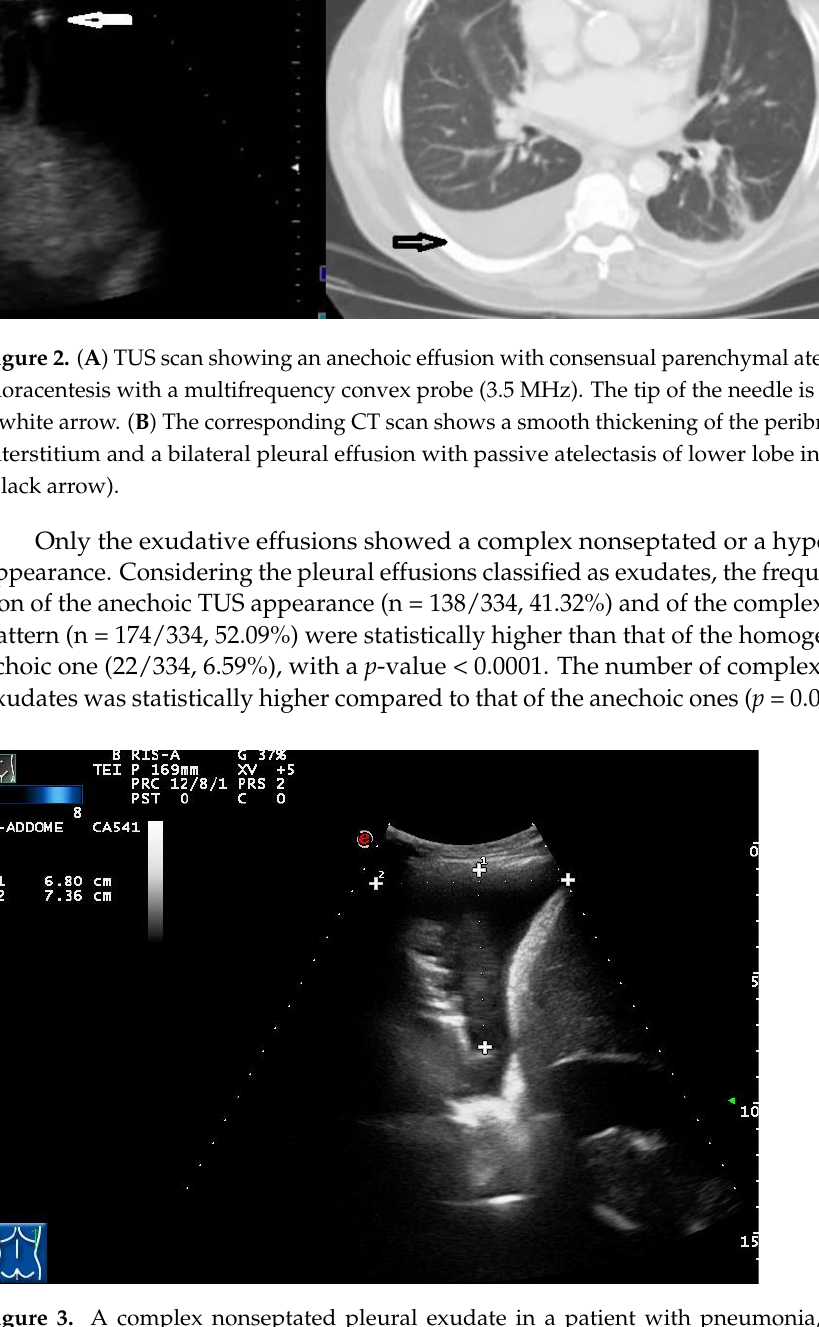
Figure 4. ( A ) TUS scan showing a homogeneous iperechoic pleural exudates viewed by a convex multifrequency probe (3.5 MHz). The drained fluid was macroscopically hemorrhagic. ( B ) The cor- responding CT scan shows a large right effusion in a patient with a diagnosis of metastatic kidney cancer. Six of the 33 effusions (18.18%) presented by patients diagnosed with heart failure were classified as exudates. Such effusions presented a complex nonseptated appearance on TUS examination (Figure 5).